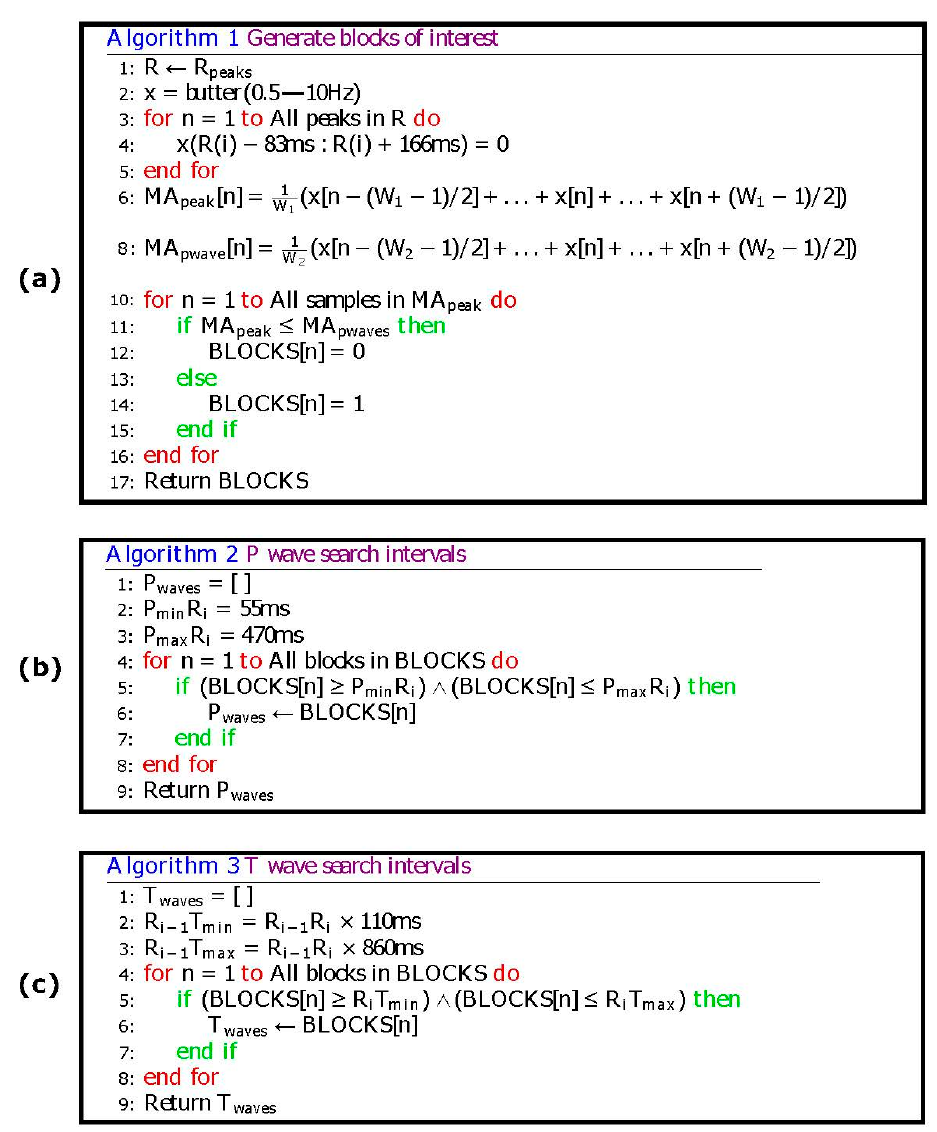
Figure 5. Pseudocode of the proposed P and T waves detection algorithm. The R i − 1 T min represents the minimum interval between the T wave and current the R peak, while R i − 1 T max is the maximum interval between the T wave and the current the R peak. Here, P min R i represents the minimum interval between the P wave and next the R peak, and P max R i stands for the maximum interval between the P wave and next the R peak. ( a ) Generating blocks of interest ( b ) P wave search intervals ( c ) T wave search intervals.